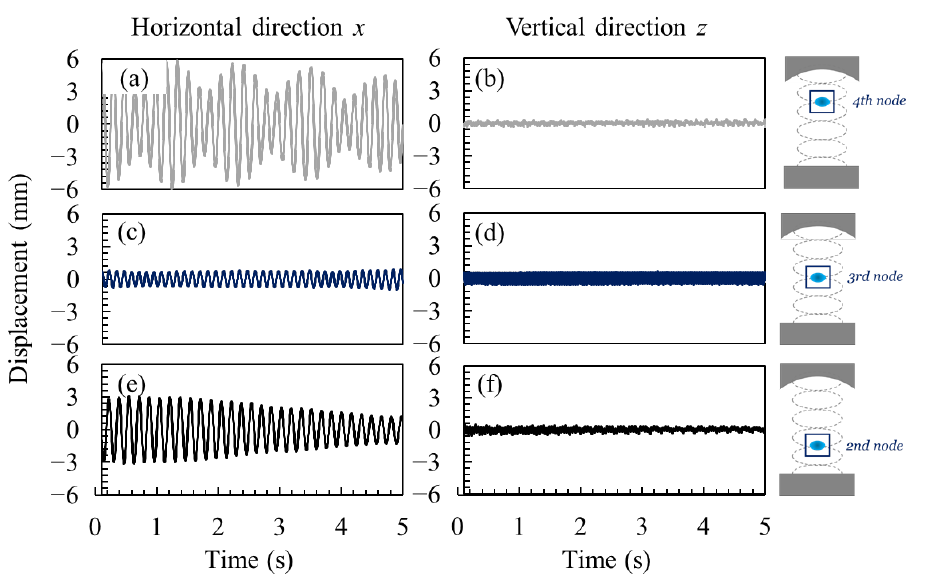
Figure 3. Oscillatory behavior of a single water droplet in an acoustic field. ( a ) Horizontal and ( b ) vertical oscillation of the droplet near the 4th node (top). ( c ) Horizontal and ( d ) vertical oscillation of the droplet at the 3rd node (center). ( e ) Horizontal and ( f ) vertical oscillation of the droplet at the 2nd node (bottom).